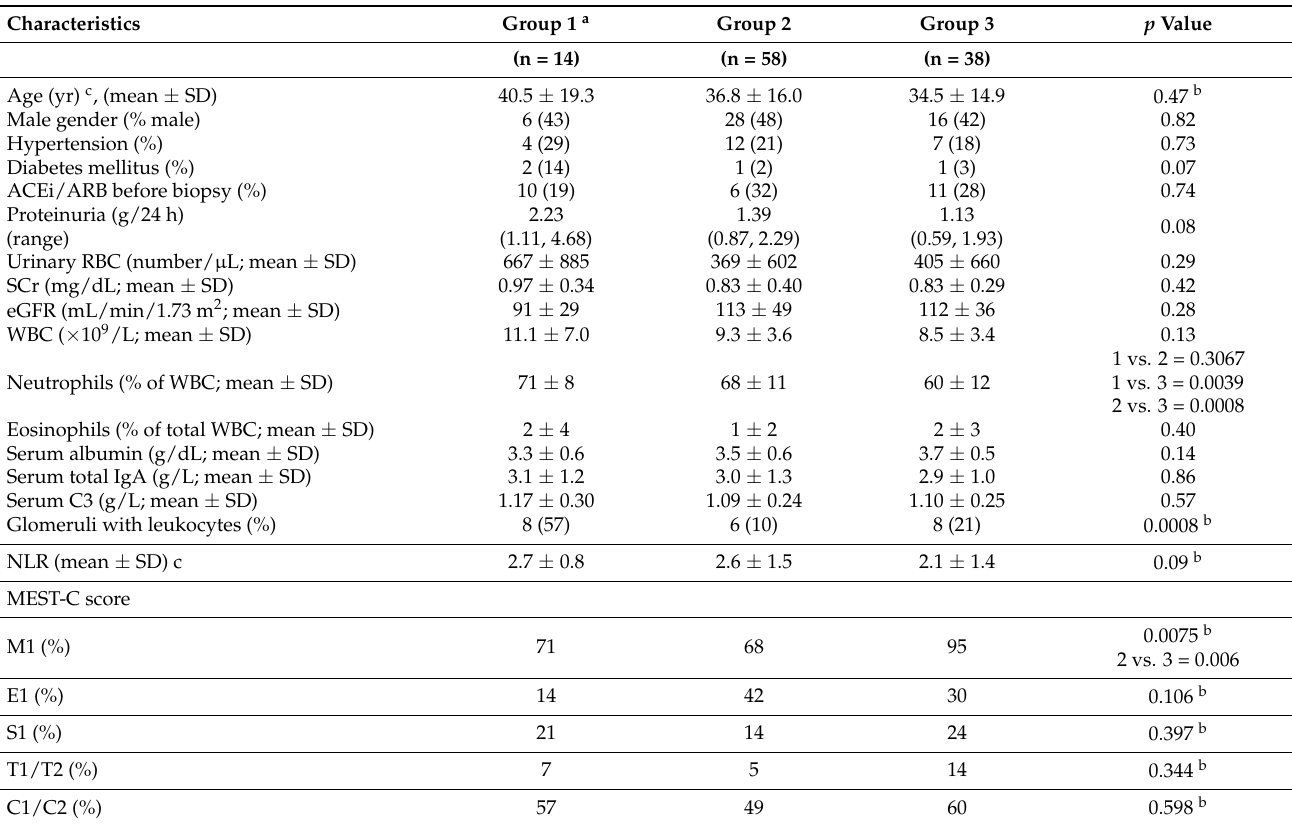
Table 3. Characteristics of 110 patients with IgAVN grouped based on the interval between purpura onset and diagnostic kidney biopsy.